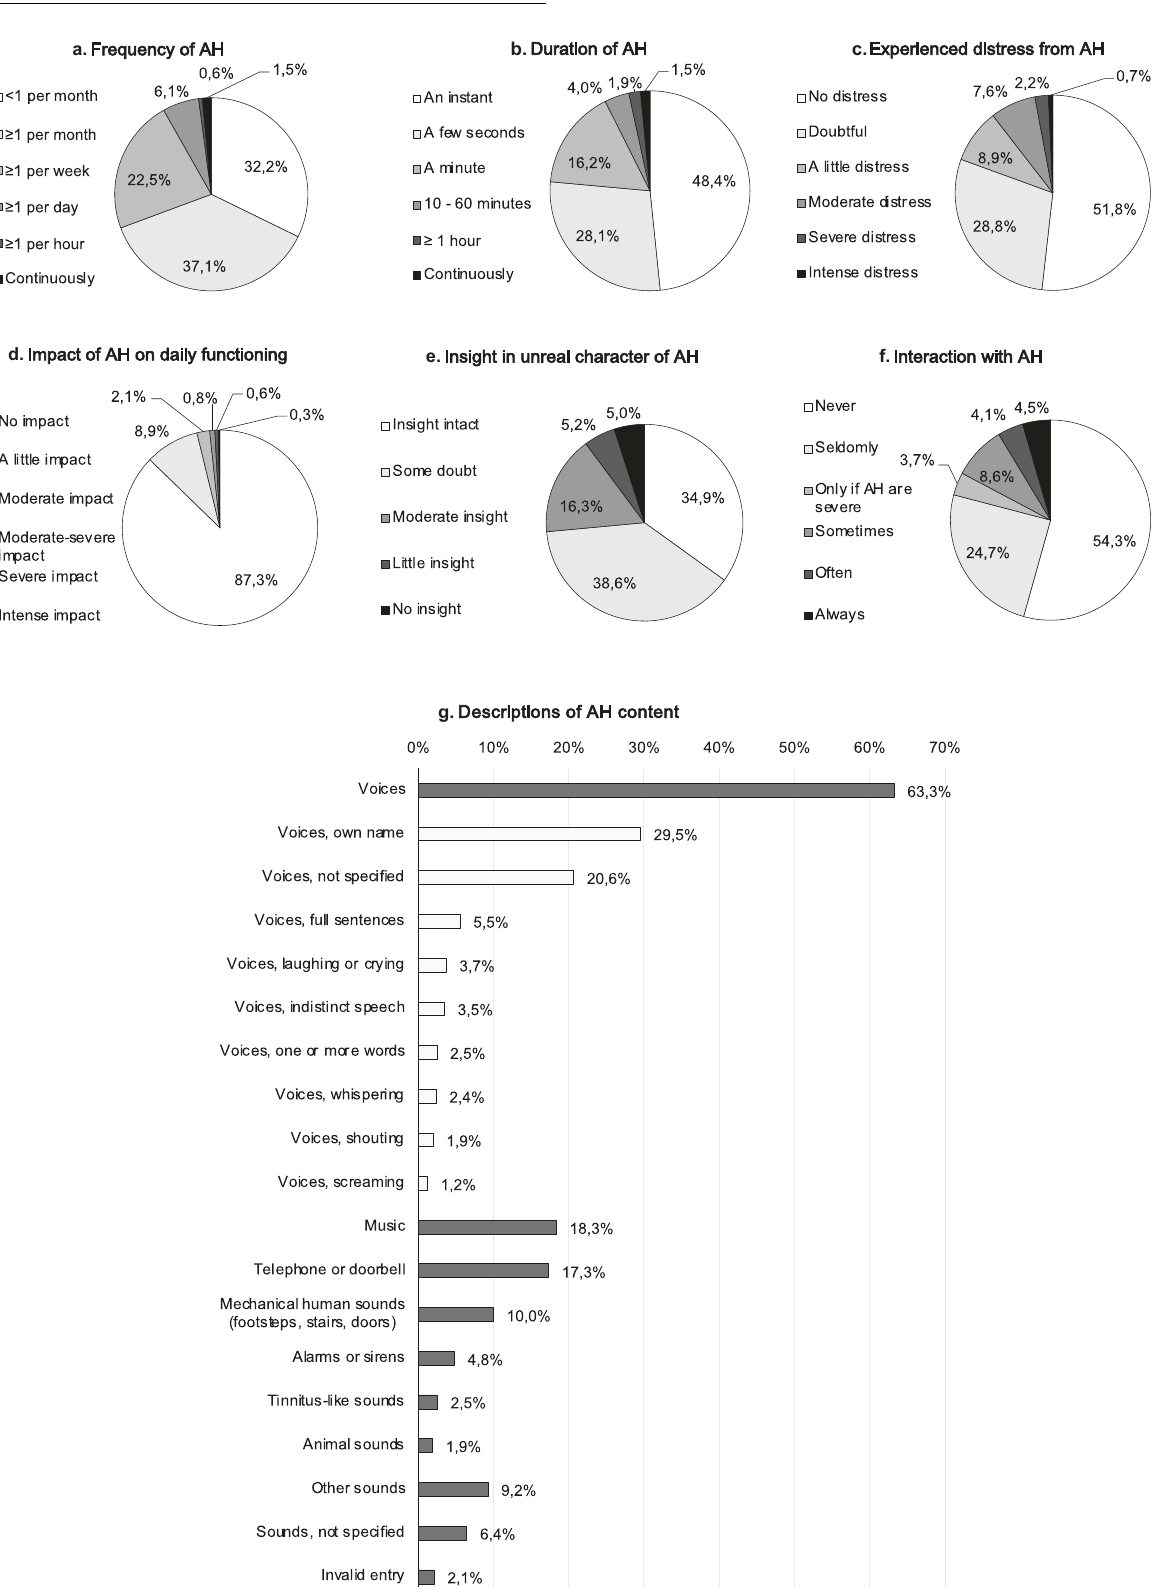
Fig. 2 Phenomenology of auditory hallucinations in the past month. Total n (AH) = 3086. Additional phenomenological items are listed in Supplementary Fig. 3. Data are listed per QPE item, as obtained through multiple choice items with one answer possibility ( a – f ) and an open question, asking participants to describe the experienced content of AH ( g , total percentage exceeds 100%). Invalid entries AH ( g ): likely external source ( n = 4); experienced while asleep ( n = 5); incomplete or incomprehensible information ( n =